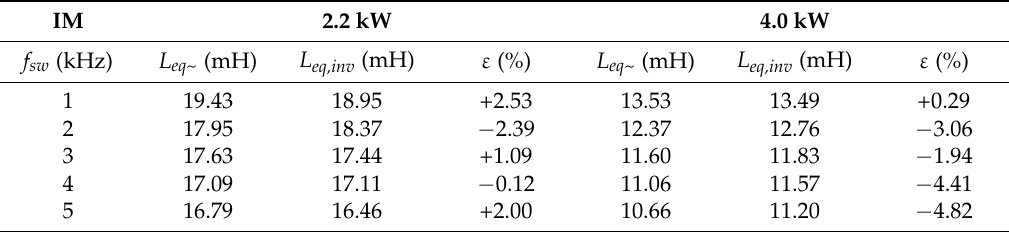
Table 2. Variance of equivalent inductance with two different supplies.